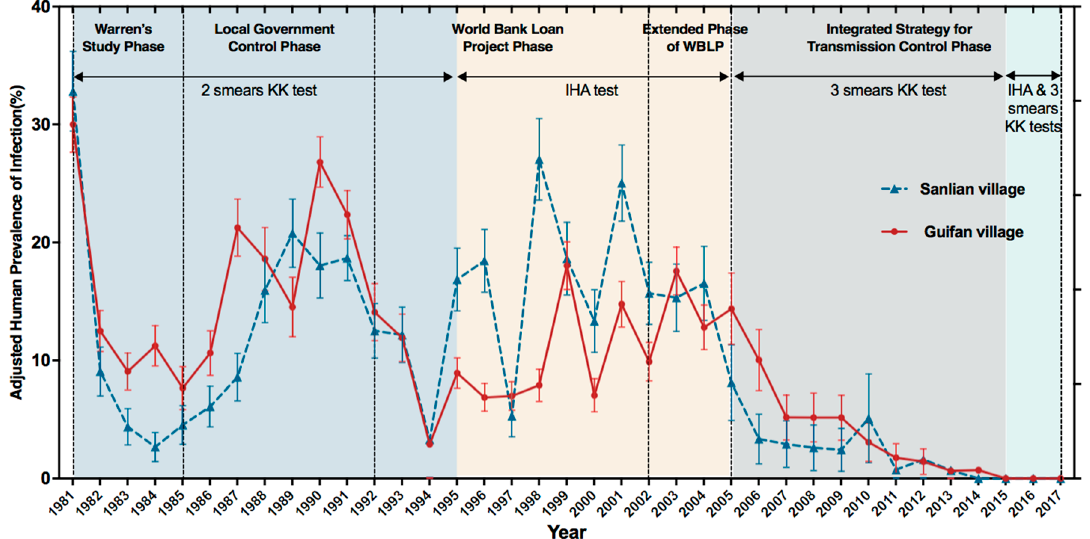
Figure 2. Prevalence of Schistosoma japonicum infection in humans in two villages during 1981–2017. (1) The adjusted prevalence formula: p ’ = P 0 + β − 1 α + β − 1 p ’: Adjusted prevalence; p 0 : Observed prevalence; α : Sensitivity; β : Specificity.[10]; (2) The Kato-Katz (KK) 2 slides method was used in 1981–1994: α = 0.64,